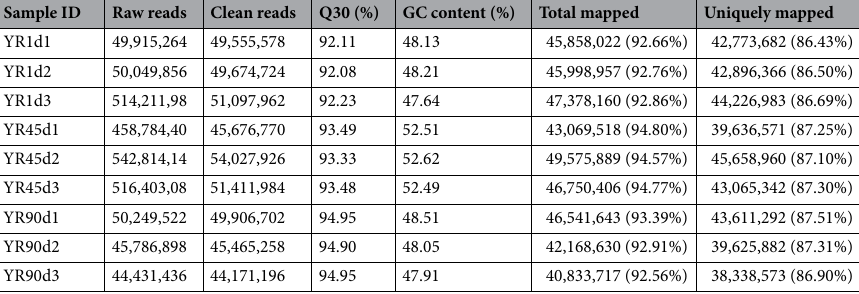
Table 1. Summary statistics of the